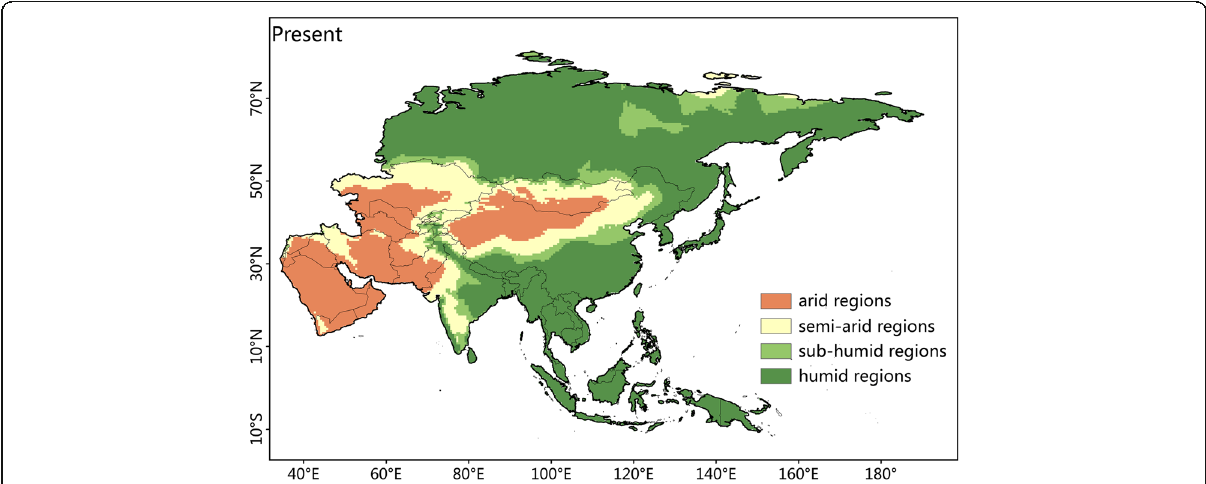
Fig. 2 Arid/humid climate regions across Asia for the present period. Arid/humid climate regions across Asia for the present period (1985 – 2005) based on CRU observation